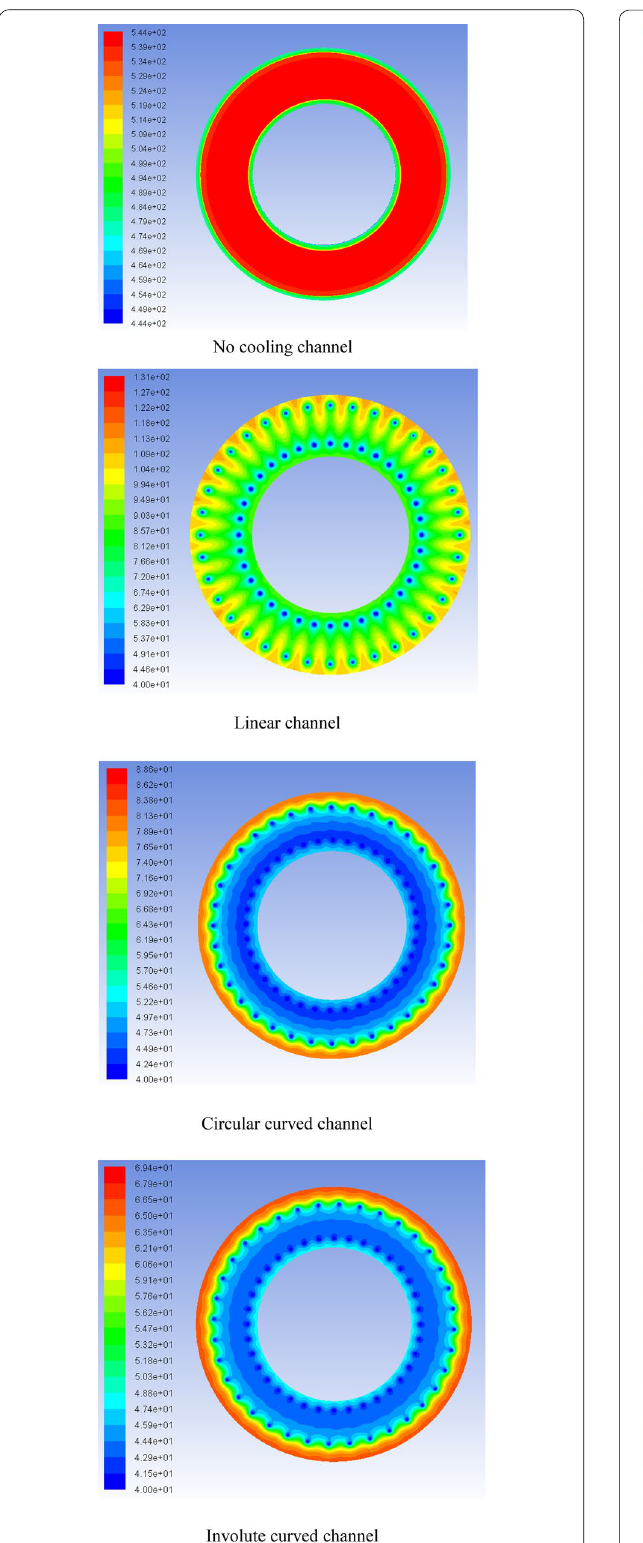
Figure 6 Cloud map of temperature distribution at the input end of different channel types (°C)